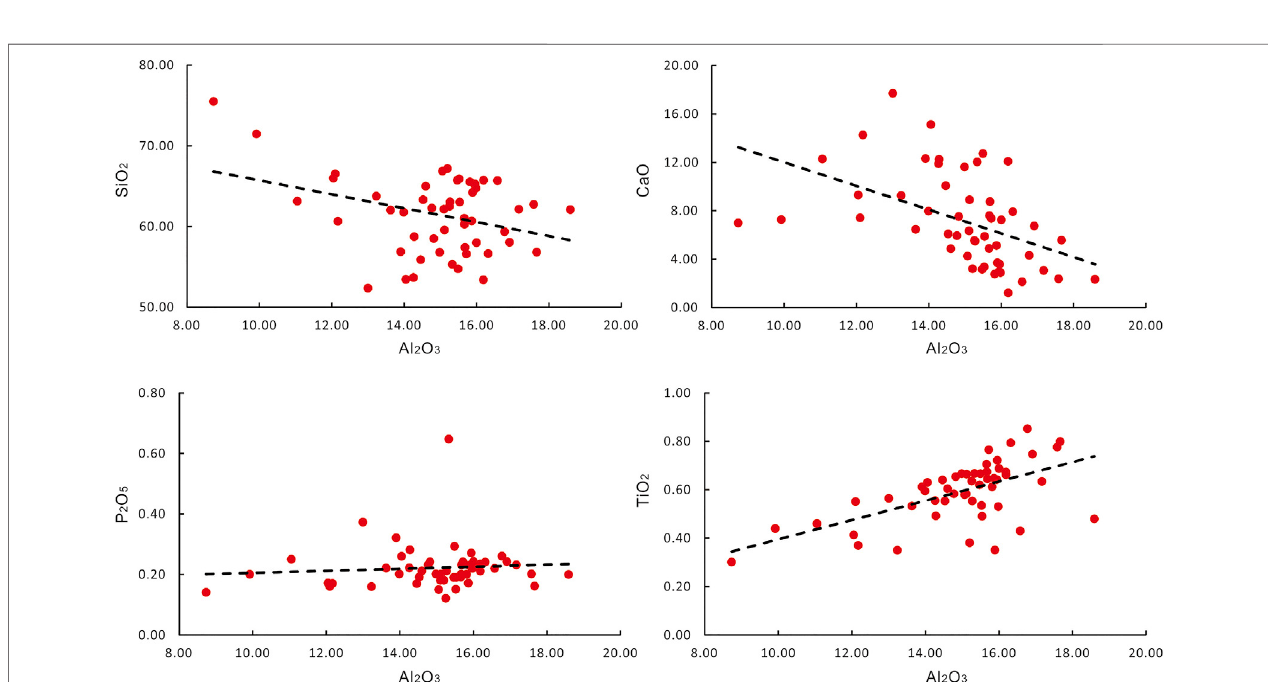
FIGURE 4 | The correlation analysis of major elements from